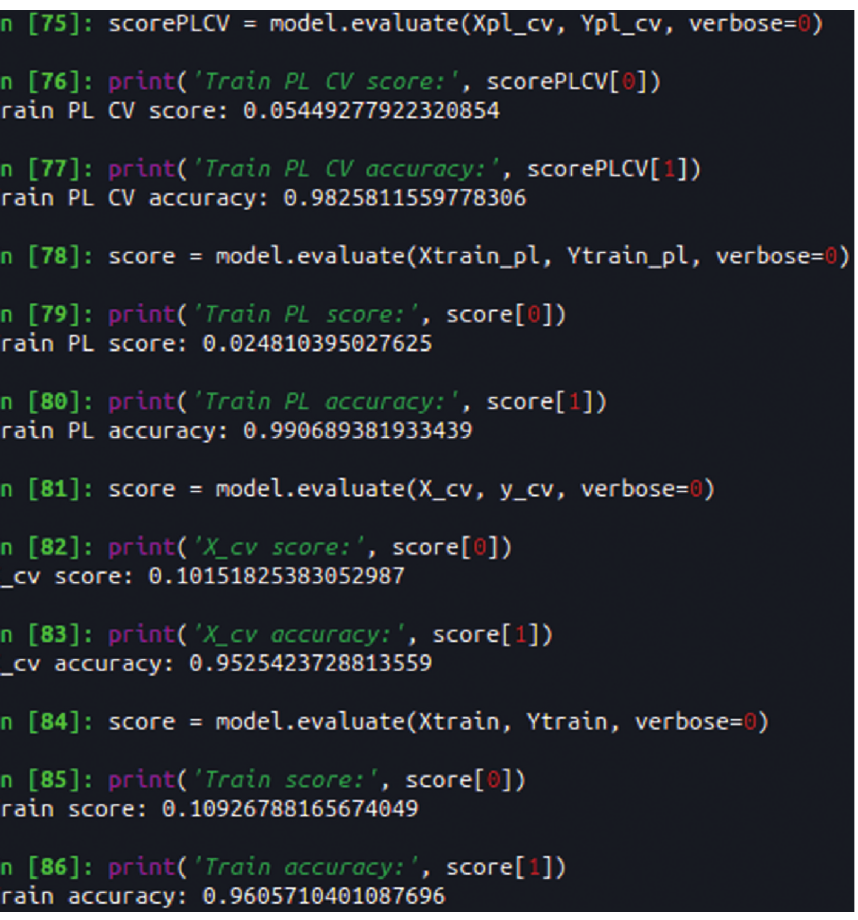
Figure 6: Pseudolabeled Training Accuracies. Table 1: Semisupervised Learning Approaches Performance Measure.